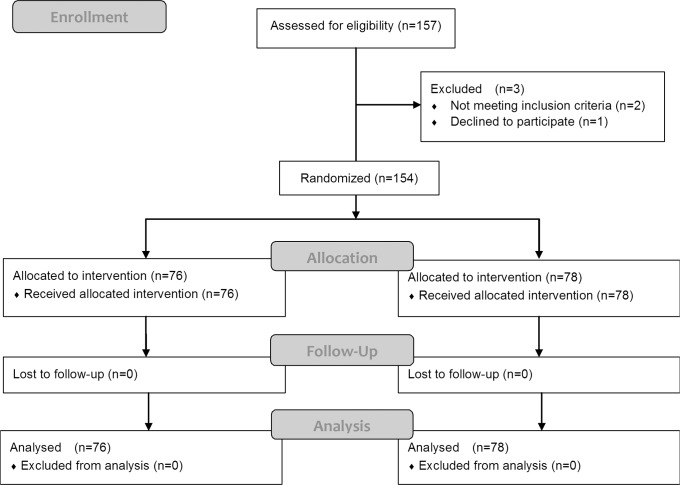
CONSORT flow chart of patient sample selection.